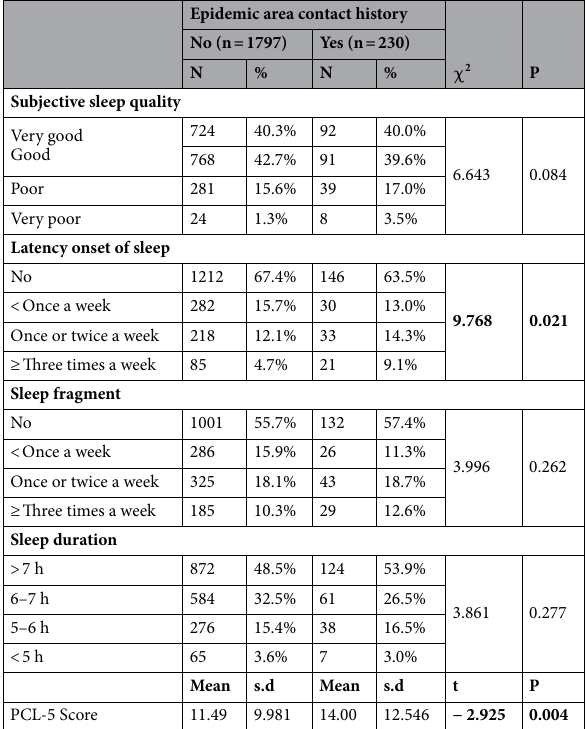
Table 2. Sleep quality and PCL-5 score by epidemic area contact history. PCL-5 PTSD Checklist for DSM-5.